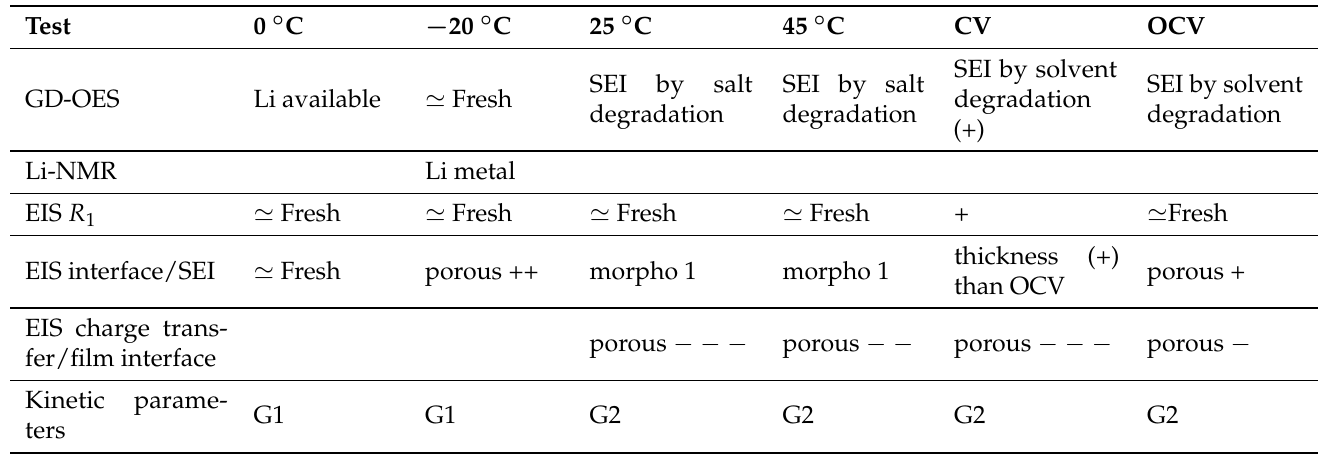
Table 2. Summary of the conclusion of the